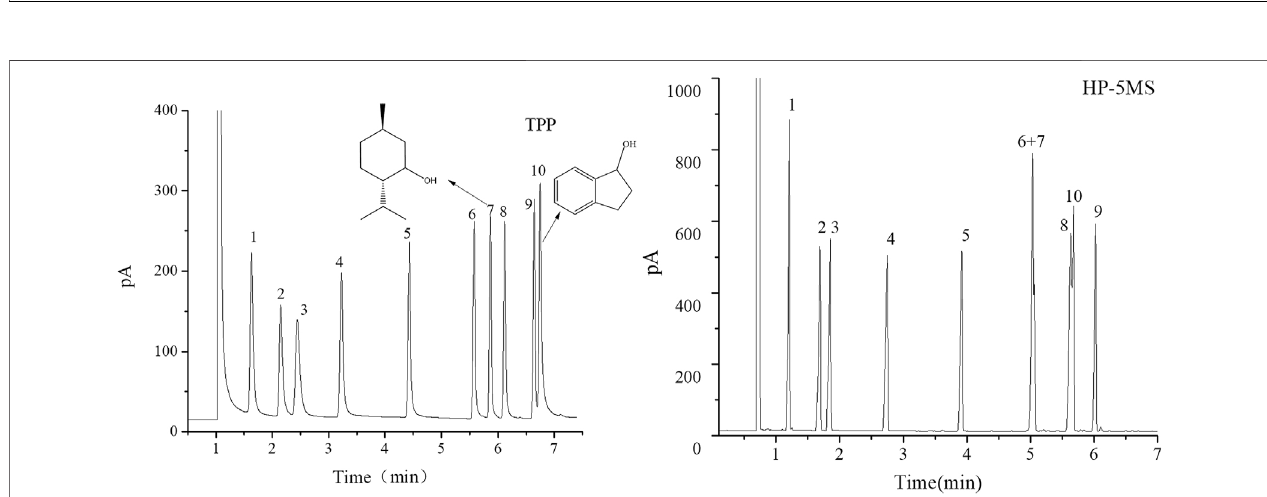
FIGURE5| GCseparationofthen-alkanesandestersmixtureontheTPPandHP-5MScolumns.Peak:(1)methylheptanoate,(2)n-decane,(3)methyloctanoate, (4) n-undecane, (5) methyl nonoate, (6) n-dodecane, (7) p-methyl ethyl benzoate, (8) n-tridecane, (9) methyl undecanoate, (10) n-tetradecane, (11) methyl dodecanoate, (12) n-pentadecane. Temperature program: 60 ° C (1 min) to 160 ° C at 10 ° C min − 1 .